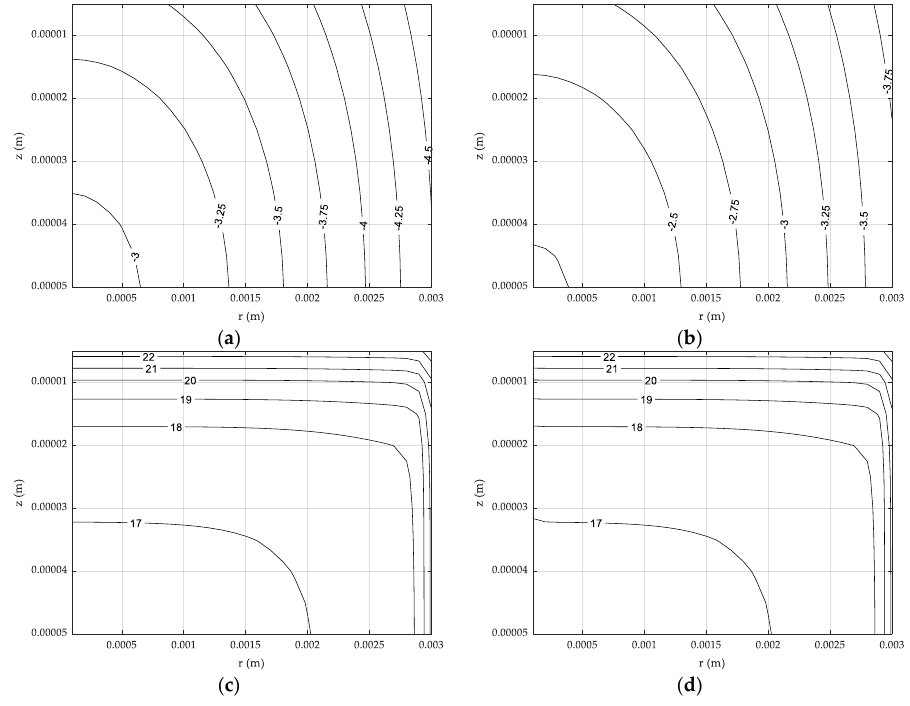
Figure 6. Distribution of the temperature and the concentration for step 3 after 10 s in the cooling phase: ( a ) T − , ( b ) T + , ( c ) Cd − , and ( d ) Cd + .